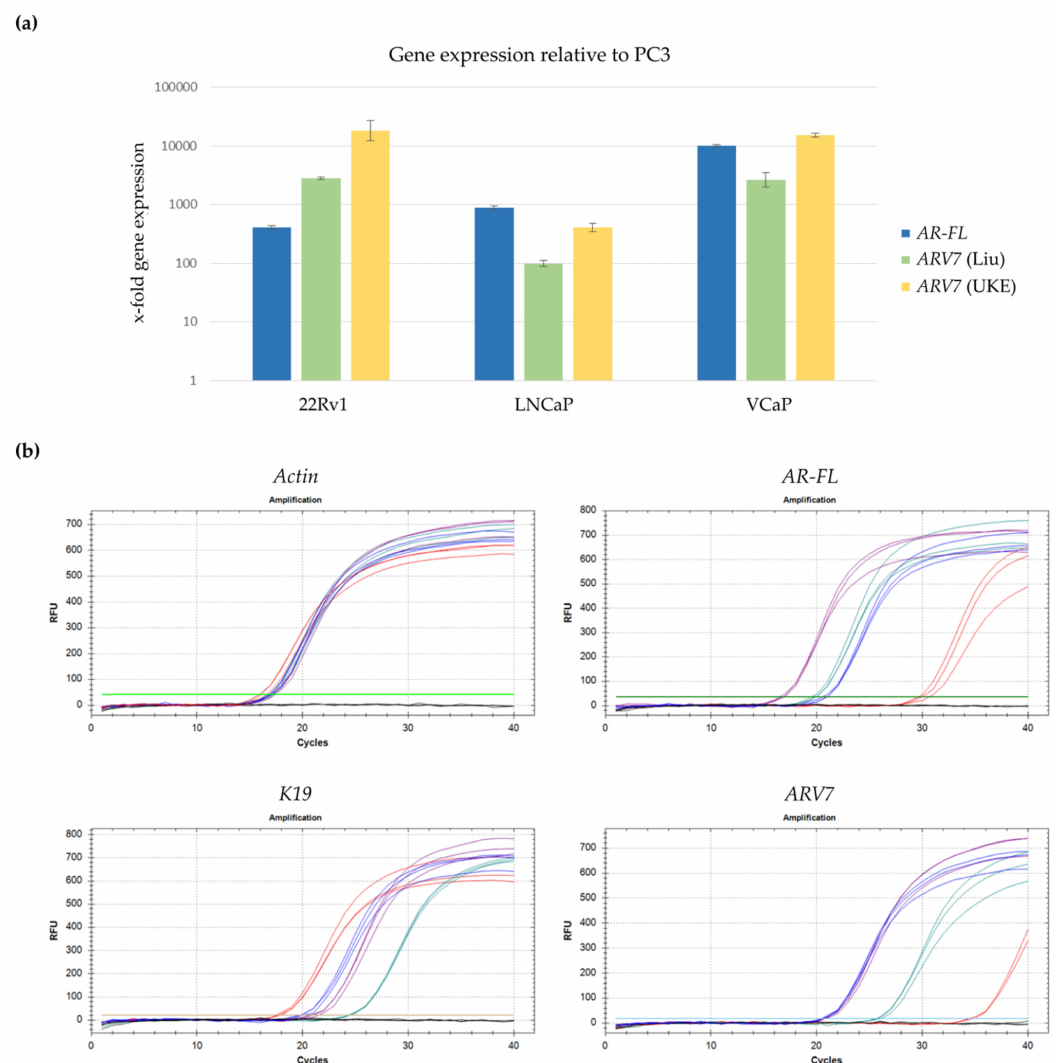
Figure 3. qPCR-based characterization of selected prostate cancer cell line cDNA. cDNA was generated from RNA isolated from 22RV1, VCaP, LNCaP, and PC3 cells and analyzed via qPCR. ( a ) Relative gene expression of AR-FL and ARV7 using primers by Liu et al. and our newly developed primers (UKE). Gene expression was first normalized to actin and subsequently displayed relative to PC3 gene expression. Standard deviation is indicated as brackets. ( b ) Representative qPCR expression profiles for di ff erent target genes ( Actin, AR-FL, K19 and ARV7 ) across all four chosen cell lines: 22RV1 (blue), VCaP (purple), LNCaP (green), and PC3 (red). All samples were applied in